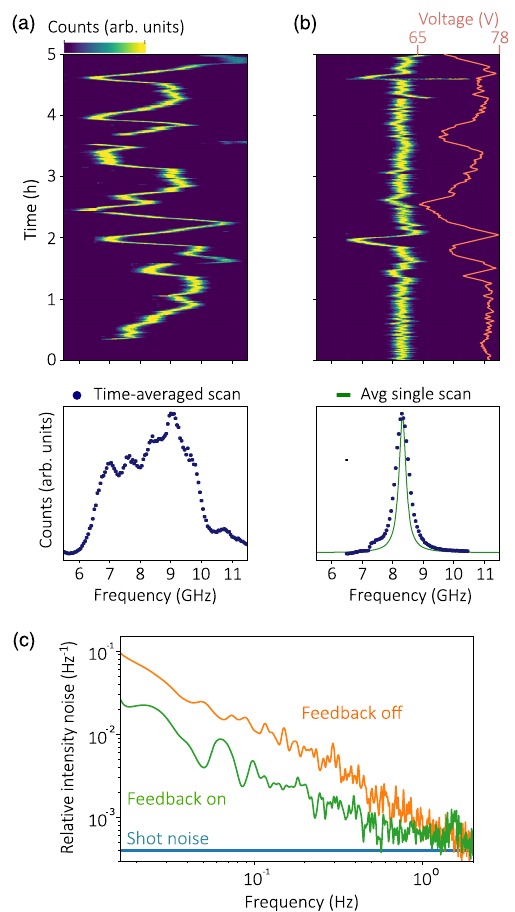
FIG. 3. Reduction of spectral diffusion using nanomechanical strain. (a) Top: Spectral diffusion of SiV center optical transition, measured over a 5-h period. Bottom: Time-averaged spectrum over the same period. (b) Top: Measurement of the SiV spectral diffusion with 20-sec pulsed feedback over a 5-h period. Bottom: Time-averaged spectra over a 5-h period (blue dots) show the reduction of total linewidth down to 500 MHz. The average of single-scan SiV linewidths is 350 MHz (green line). (c) Power spectral density of measured SiV count fluctuations with (with- out) feedback is presented by the green (orange) line, showing reduction of noise by an average of 8 dB. Blue line indicates statistical noise limit set by finite photon emission and collection